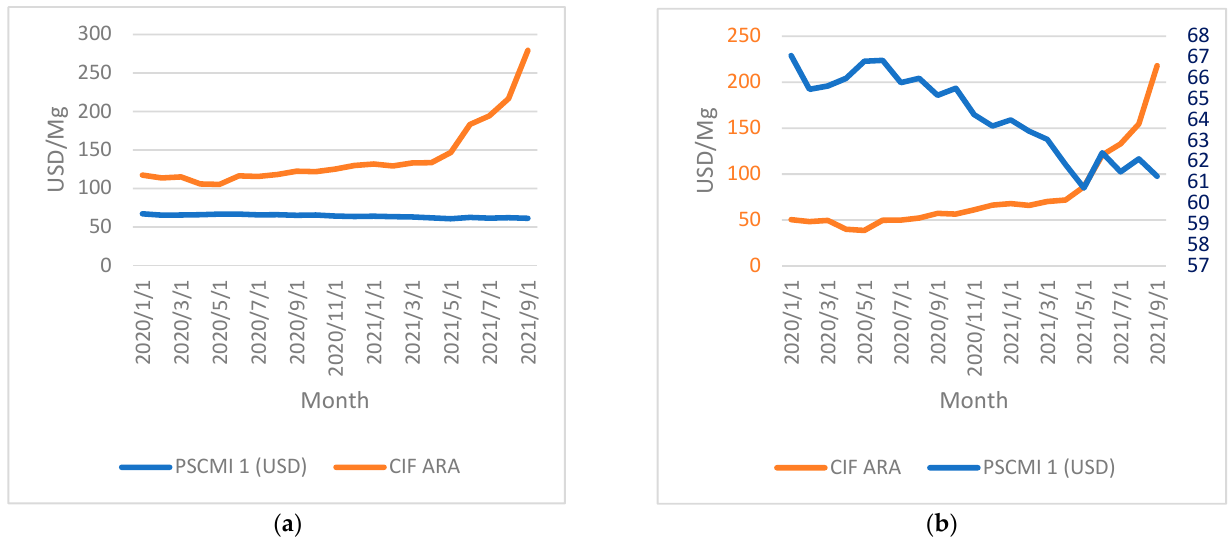
Figure 5. CIF ARA hard coal prices and the PSCMI 1 indicator [32]. ( a ) one y axis; ( b ) an auxiliary axis.